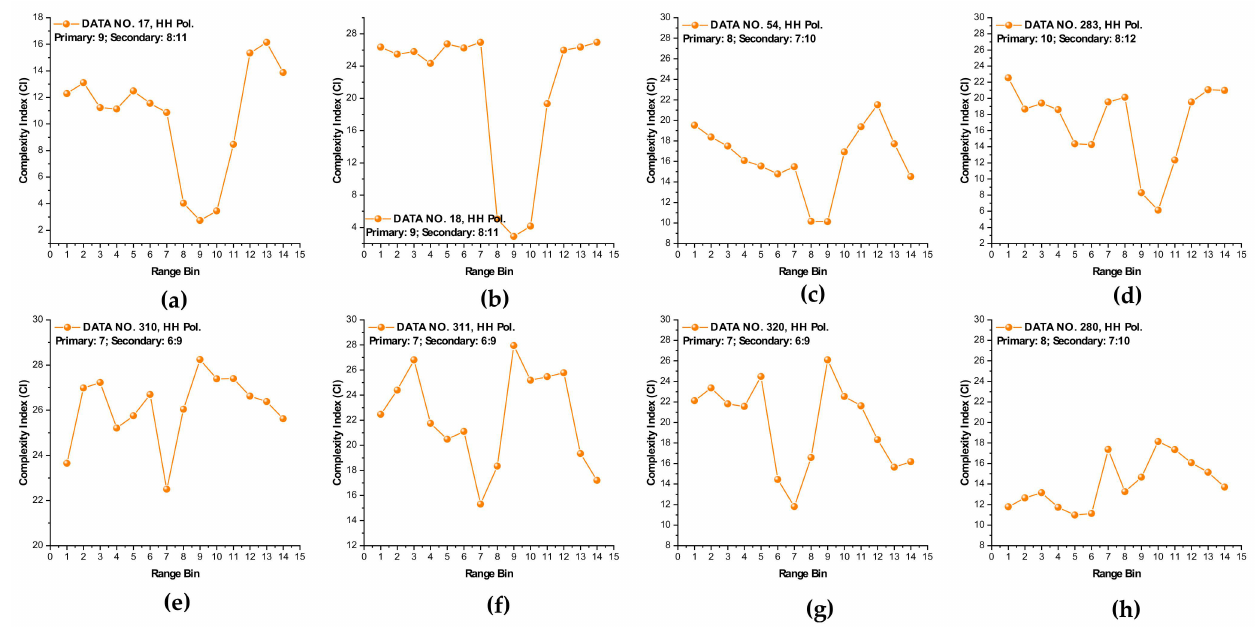
Figure 8. ( a – h ) Complexity indices of data sets 17, 18, 54, 280, 283, 310, 311, and 320 (HH polarization, under the same parameters as Figure 6).